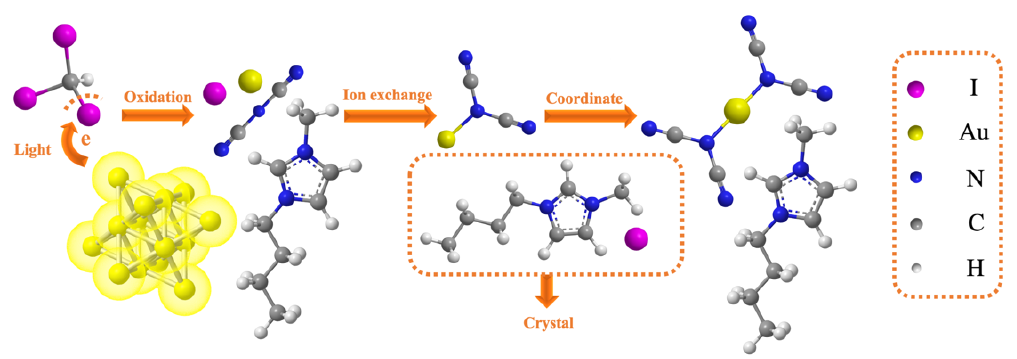
Figure 8. Reaction mechanism diagram.